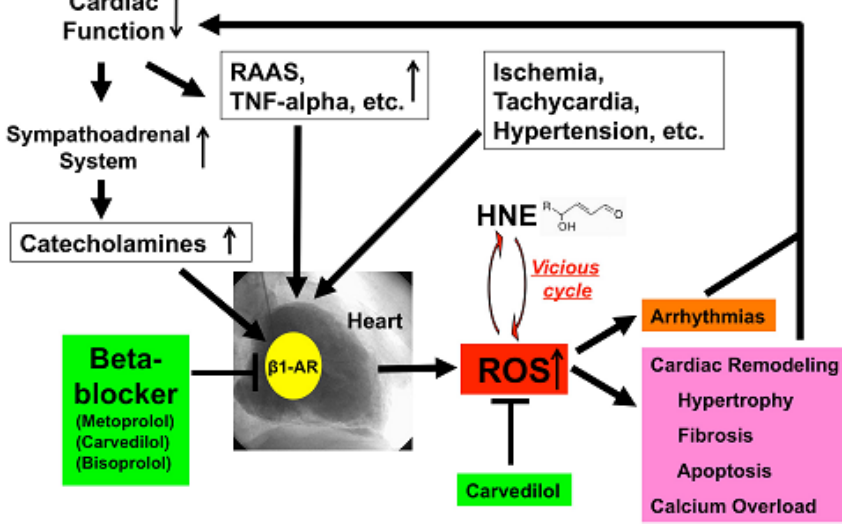
Figure 5. Termination of vicious cycles of oxidative stress and depressed cardiac function by treatment with a